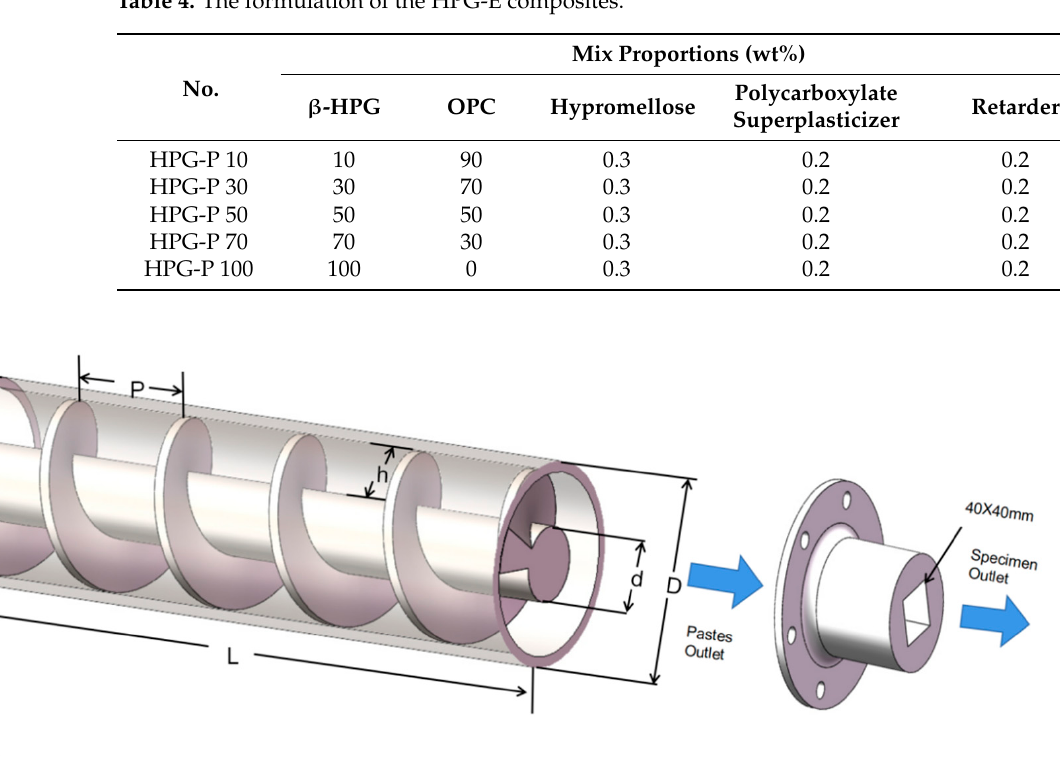
Scheme 1. Geometry parameters of the single-screw simulation. Table 4. The formulation of the HPG-E composites.